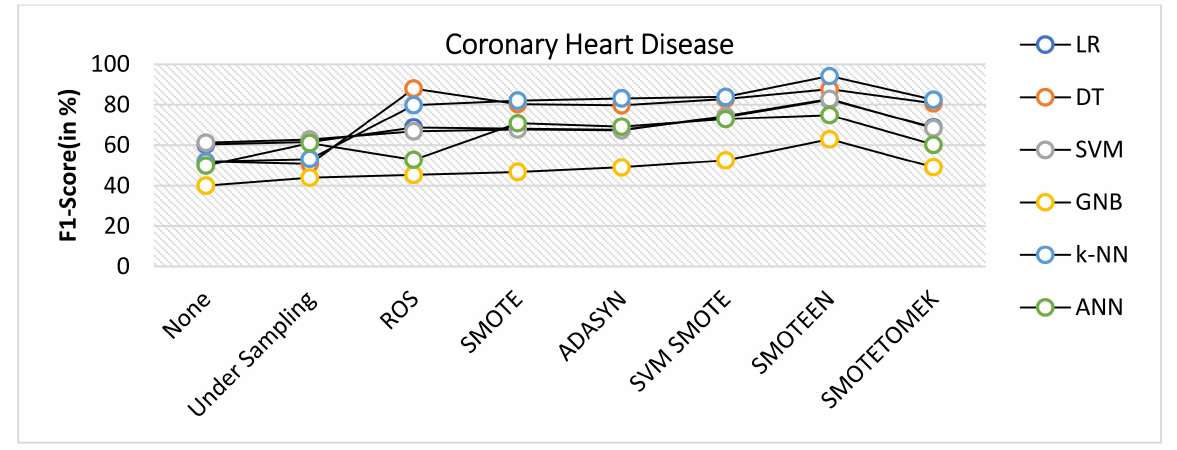
Figure 21. F1 score for coronary heart disease dataset of balancing algorithms over six classifiers.